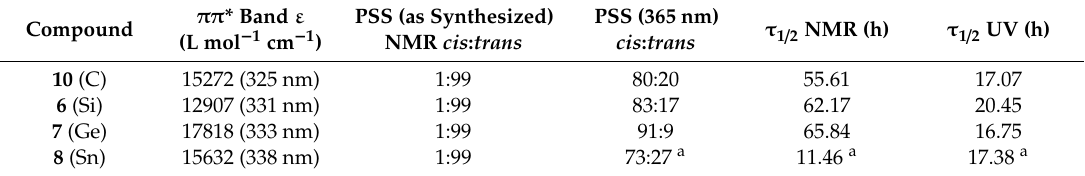
Table 7. Collected data of the absorption spectra and switching